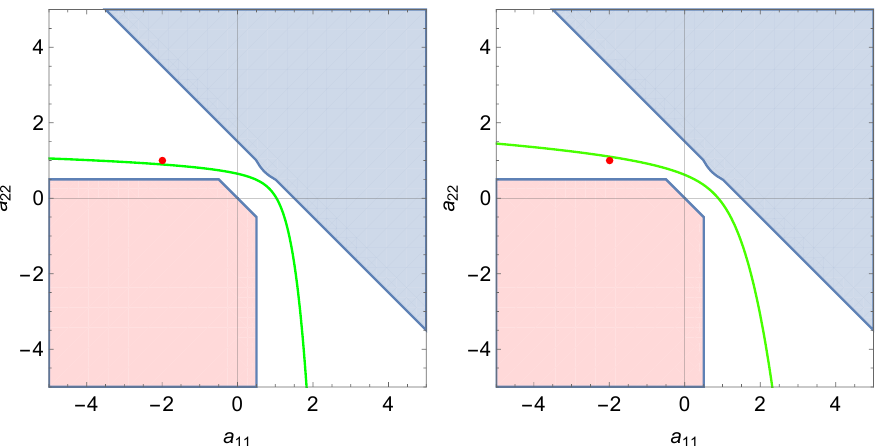
Figure 6. Position of the point ( a 11 , a 22 ) = ( − 2,1 ) (plotted in red) with respect to curve Γ ( δ , q 1 , q 2 ) (shown in green) in the particular case ( q 1 , q 2 ) = ( 0.2,1 ) (left plot) and ( q 1 , q 2 ) = from Example